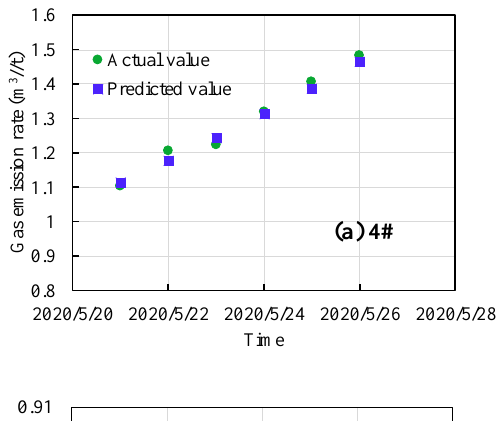
Figure 6. Comparison of gas prediction and actual data in the intake and return air roadways of the working face. ( a ) 1# location; ( b ) 2# location; ( c ) 3# location.